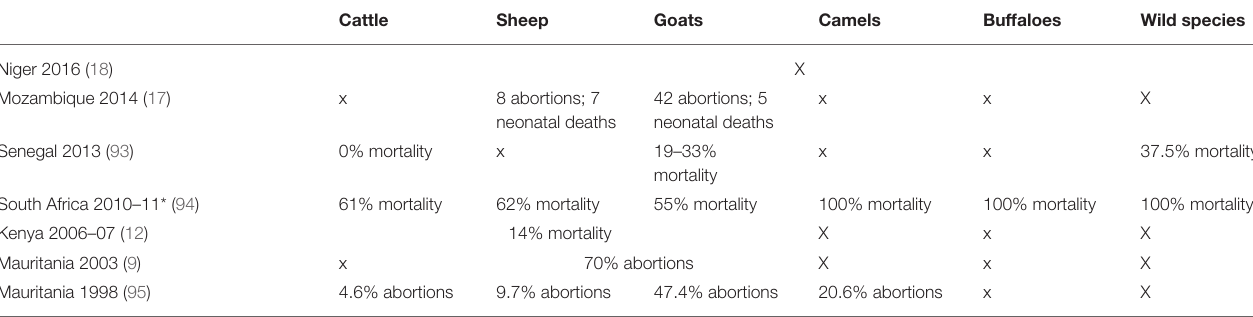
TABLE 1 | Rates of mortality in animals during recent RVFV outbreaks. Cattle Sheep Goats Camels